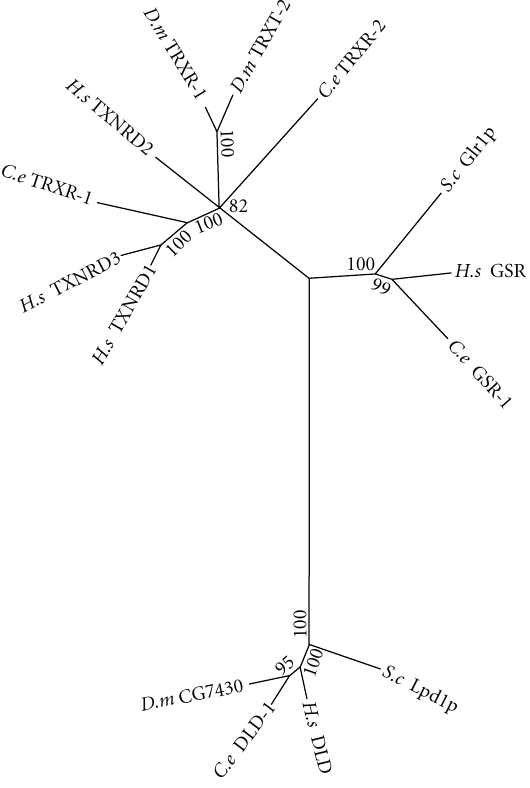
Figure 6: Maximum likelihood majority-rule bootstrap consensus tree of thioredoxin reductase (TRXR), glutathione disulfide reduc- tase (GSR) and dihydrolipoamide dehydrogenase (DLD) proteins. C. elegans possess two TRXR: mitochondrial TRXR-1 and cytosolic TRXR-2. In addition C. elegans contain a single glutathione disulfide reductase (GSR) and the closely related DLD. See Figure 5 for details of how the sequences were identified and processed as well as how the phylogenetic analysis was carried